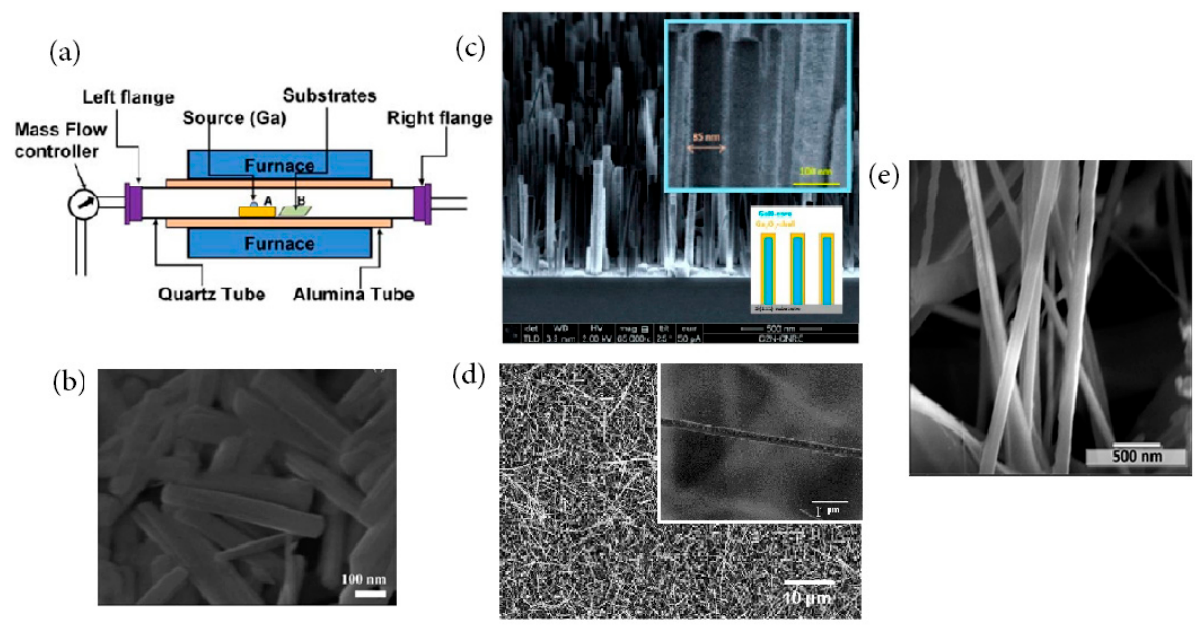
Figure 6. ( a ) Schematic experimental setup of the CVD furnace for the growth of Ga 2 O 3 nanostruc